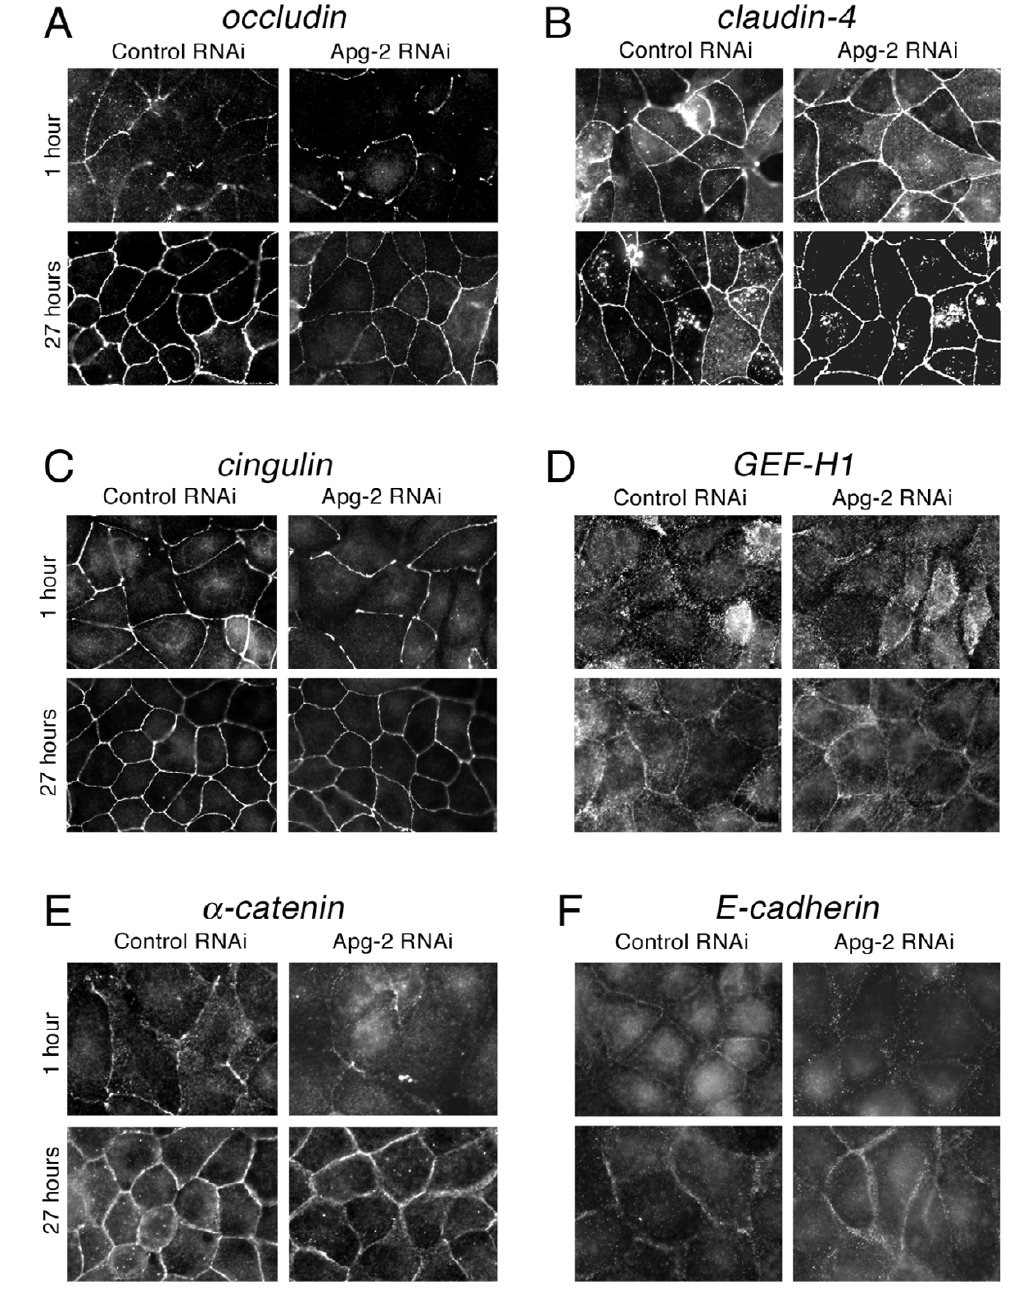
Figure 5 Retardation of junction formation by Apg-2 depletion . Control and Apg-2 RNAi cell lines were cultured and processed as in figure 3 and then stained with antibodies against the transmembrane proteins occludin (A) and claudin-4 (B), the junctional plaque components cingulin (C) and GEF-H1 (D), and the adherens junction proteins α -catenin (E) and E-cadherin (F). Shown are images derived from samples fixed after 1 hour and 27 hours of junction formation. Note, retardation of junctional recruit- ment was observed for occludin, cingulin, α -catenin and E-cadherin. GEF-H1 became only concentrated at tight junctions after longer time points of junction formation. Claudin-4 was present at the plasma membrane at all time points but only appeared to be concentrated at junctions at later time points. GEF-H1 and claudin-4 distributions were not affected by depletion of Apg-